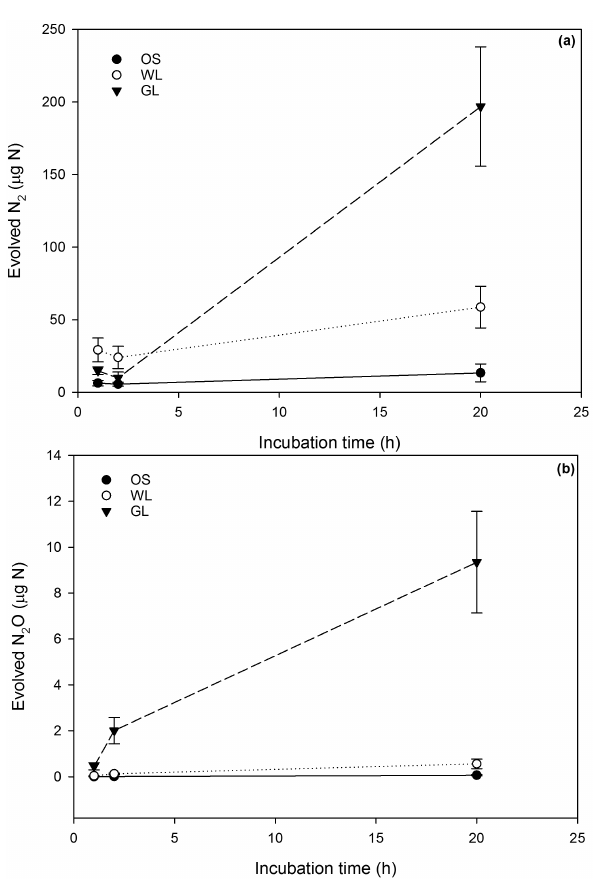
Figure 2. Evolved (a) N 2 and (b) N 2 O gas measured between 1, 2, and 20h incubation time intervals using the 15 N gas-flux method in the organic soil (OS), woodland (WL), and grassland (GL) land use types. Data points are means and the error bars represent standard errors.